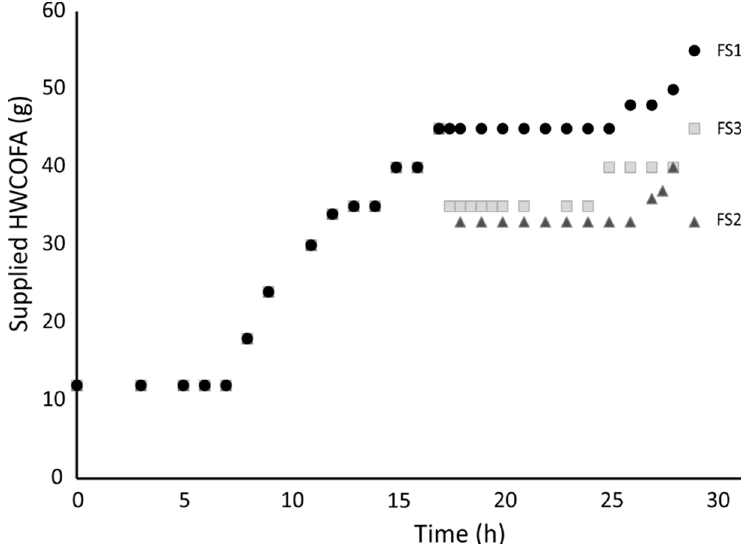
Figure 2. Hydrolysed waste cooking oil fatty acids (HWCOFA) pulse feeding strategies. Feed strategies FS2 and FS3 have the same feed profile as FS1 up to T17 hours after, at which time the number of pulses and the amount of HWCOFA supplied was different to FS1. FS1 supplied a total of 967 g of HWCOFA, FS2 804 g of HWCOFA, and FS3 844 g of HWCO, in 30 h fermentation. The starting volume of the culture was 3 l, which increased to 4.2 l for FS1 and FS3 and to 4.1 l for FS2.